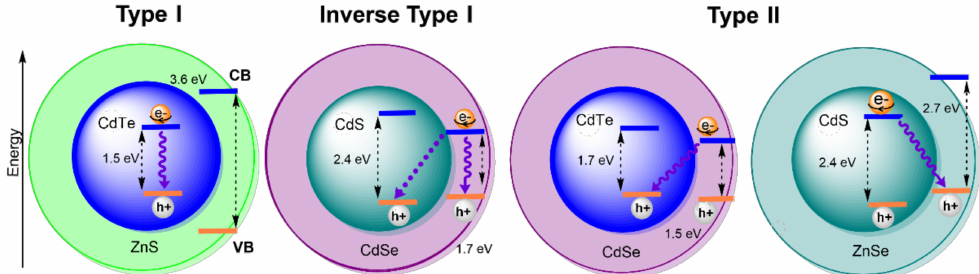
Figure 2. Schematic representation of the three main types of CS QDs: Type I, Inverse type I and Type II, of which CdTe/ZnS, CdS/CdSe and CdTe/CdSe, as well as CdS/ZnSe, are examples. Band gap energies ( E g ) for the semiconductor materials used as examples are indicated. Electron-hole recombination is indicated by a wavy